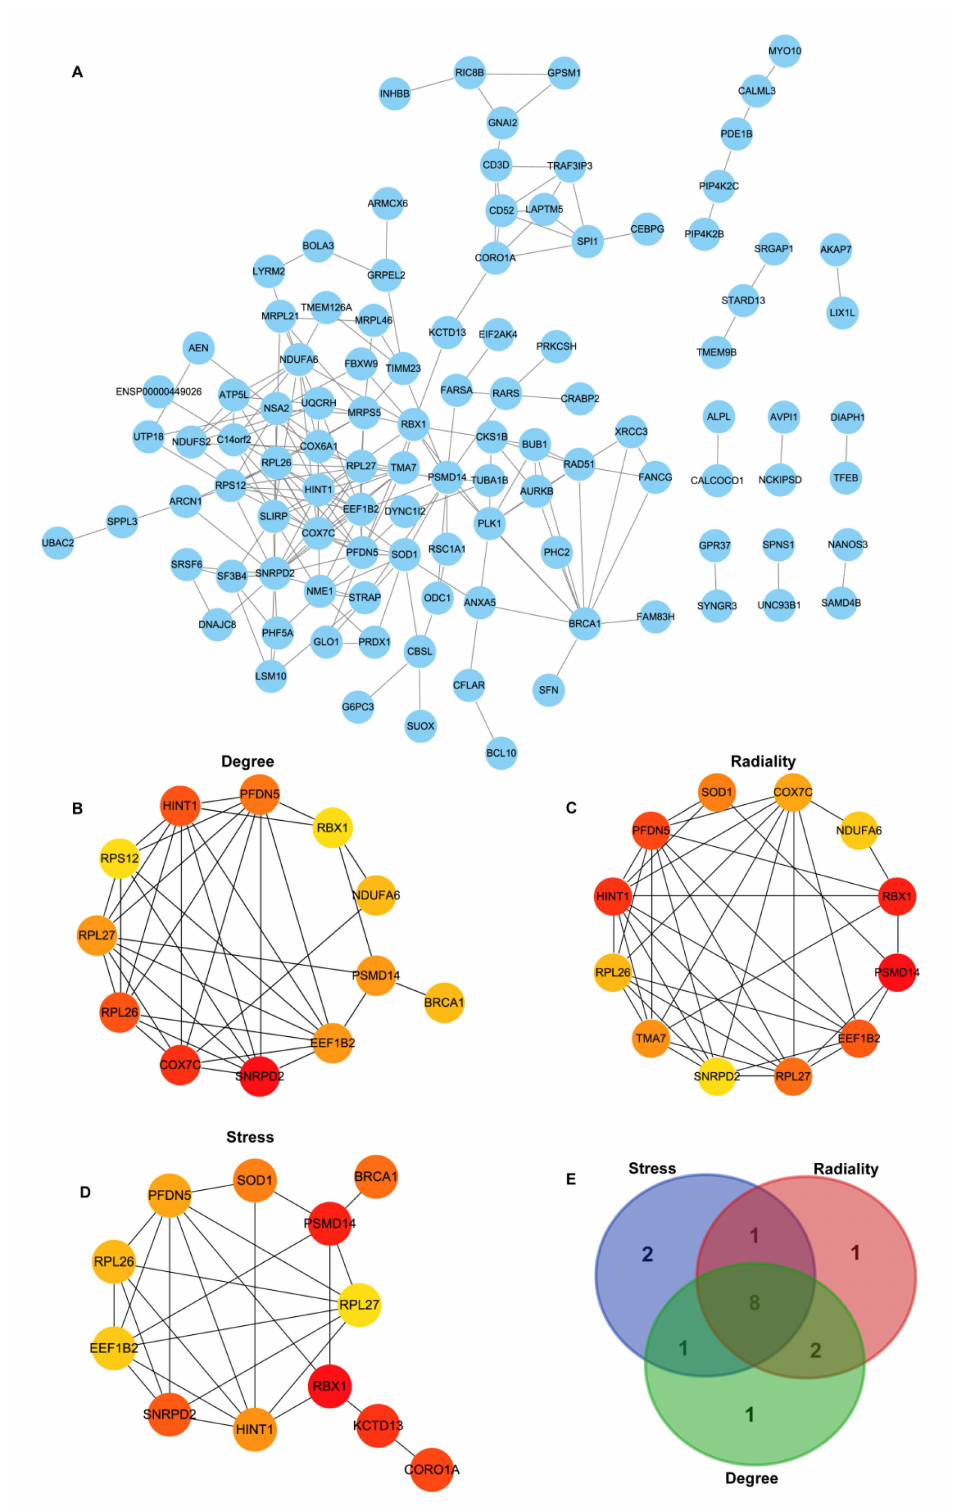
Figure 3. PPI network for DEGs and the identification of hub genes. ( A ) The PPI network was constructed from DEGs using the STRING database. ( B , C ) Top 12 hub genes identified by different algorithms in cytoHubba, including Degree ( B ), Radiality ( C ), and Stress ( D ). ( E ) Common hub genes identified between the 3